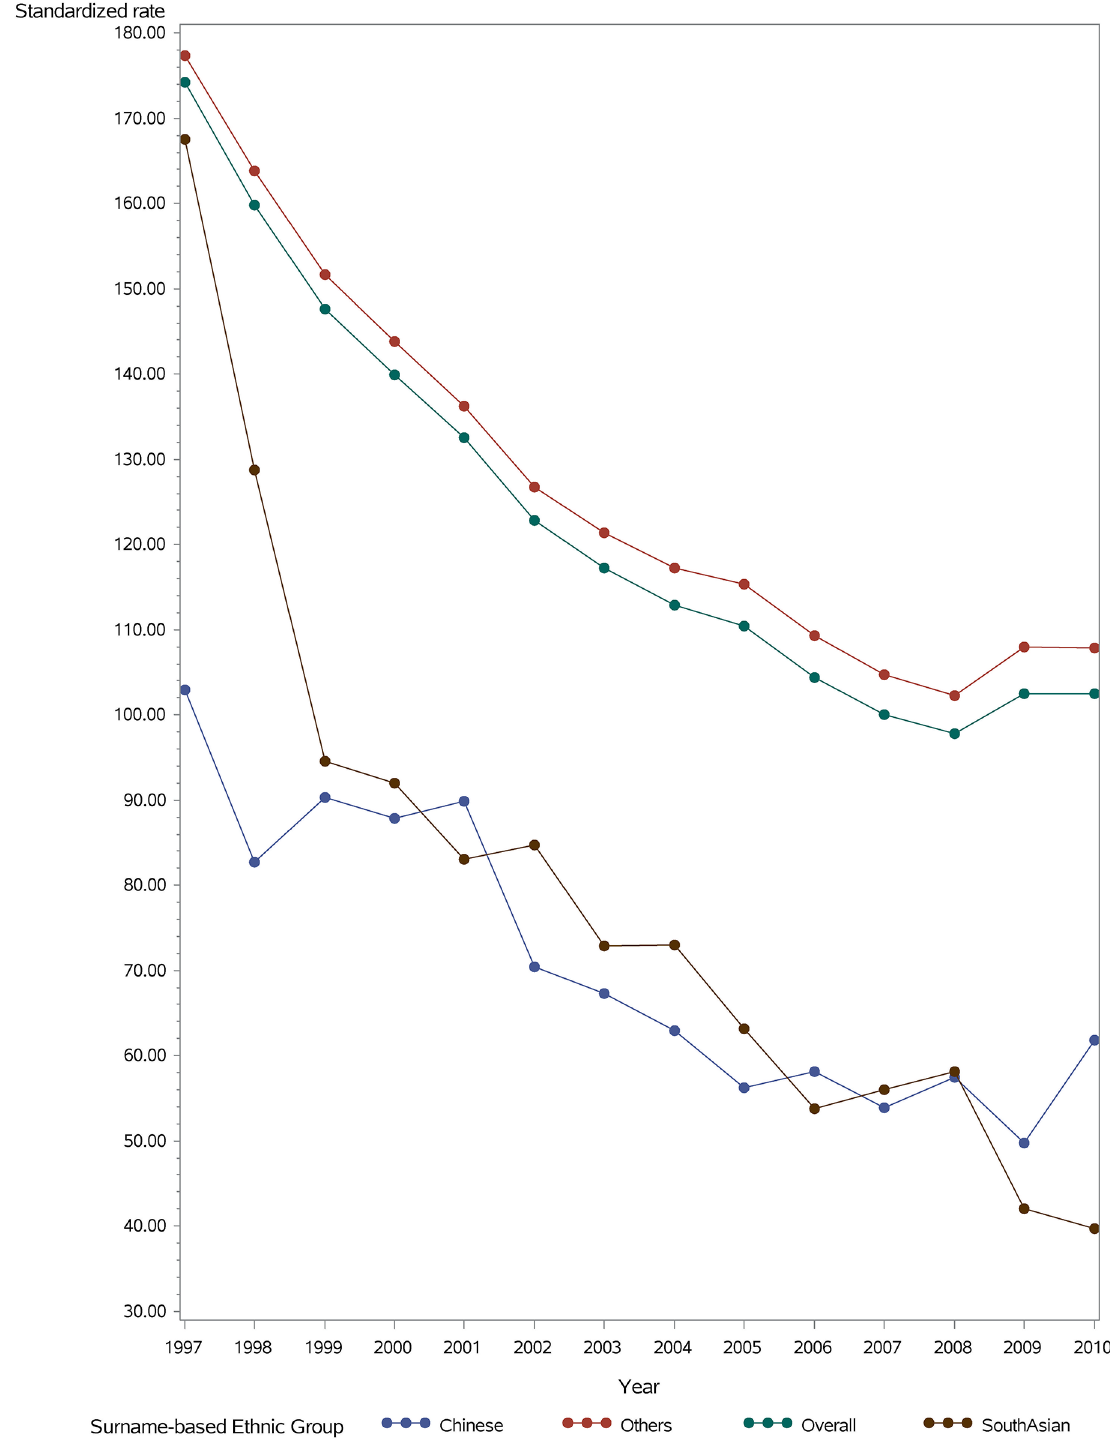
Fig 2. Age and sex standardized incidence of ischemic stroke per 100,000persons by ethnic group, 1998to 2010.